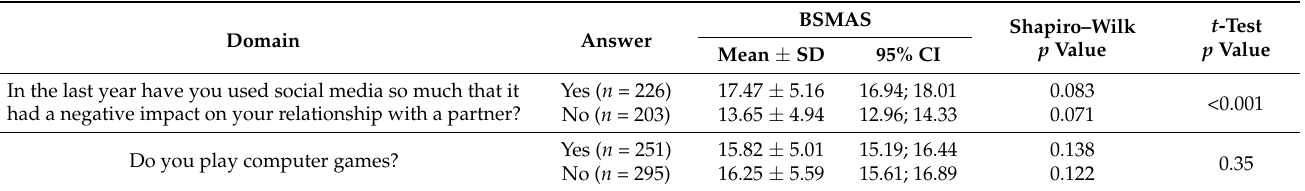
Table 5. Bergen Social Media Addiction Scale scores in relation to extensive social media use and playing computer